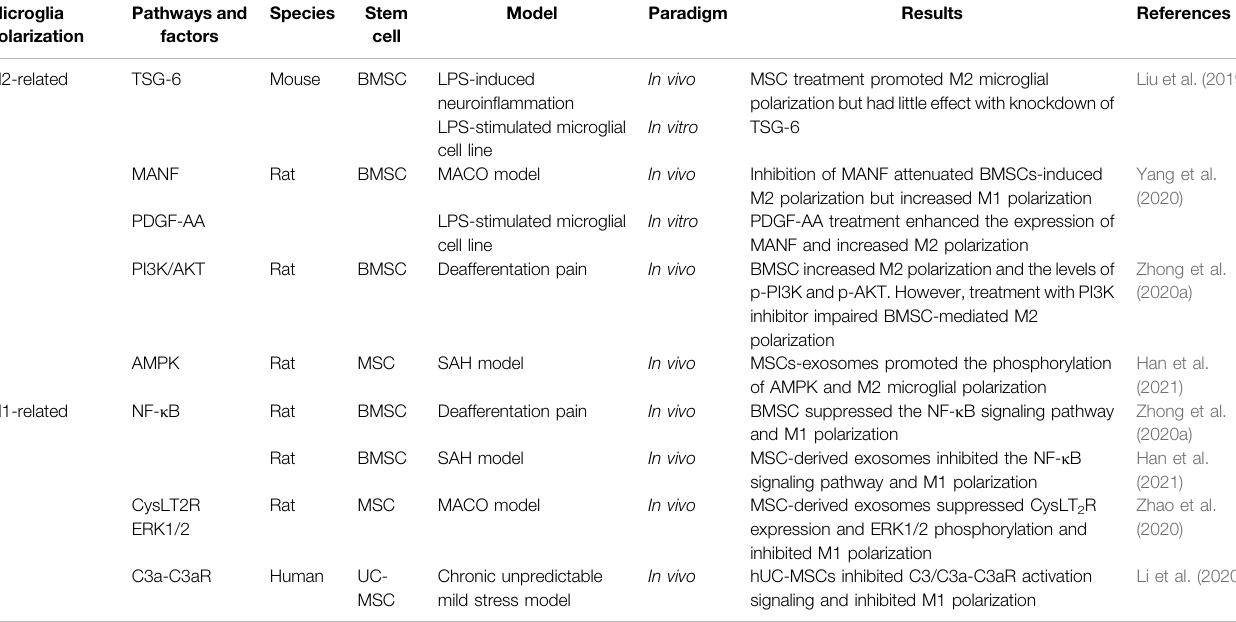
TABLE 1 | Related pathways and factors of MSC regulating microglia polarization. Microglia